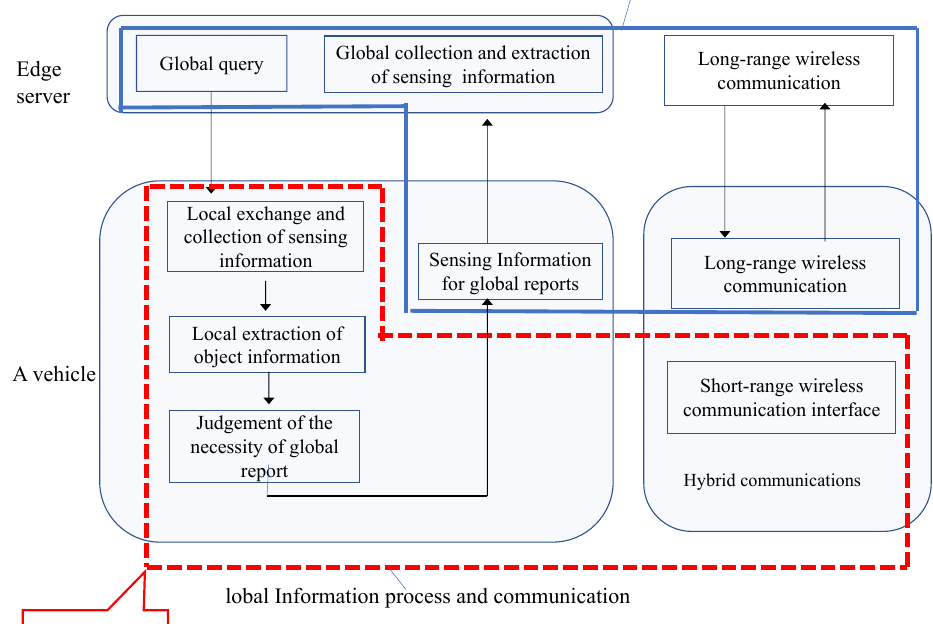
Figure 2. Method